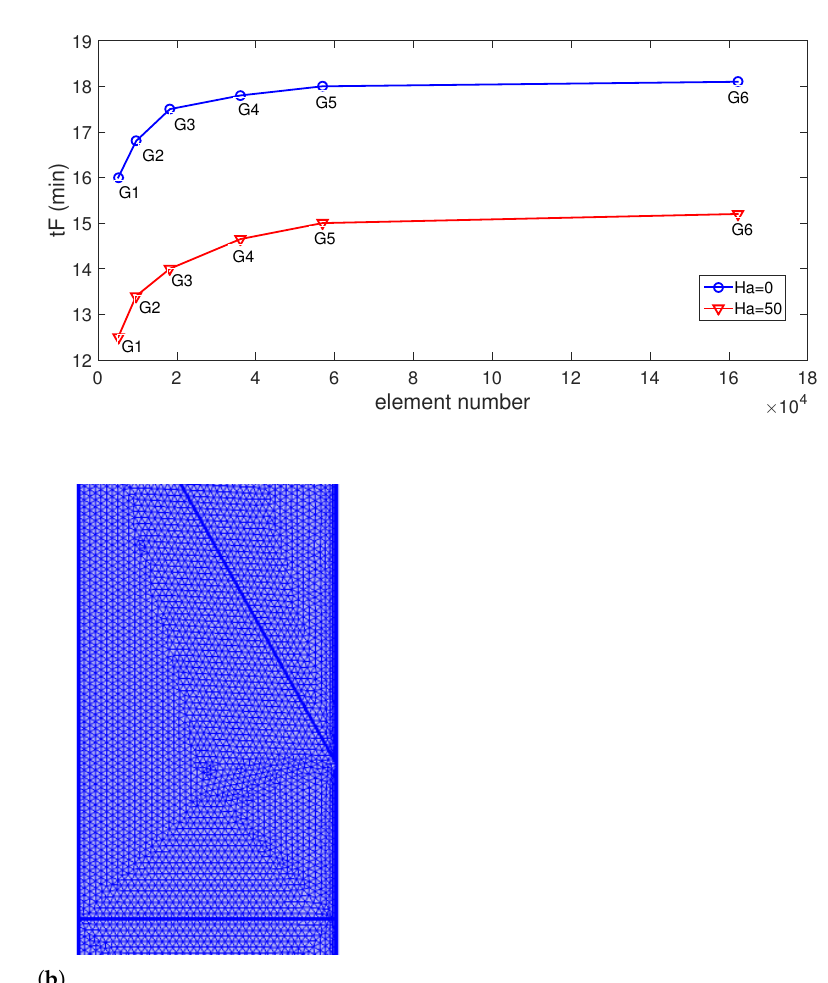
Figure 5. The maximum deviation of − 9.3% is observed.